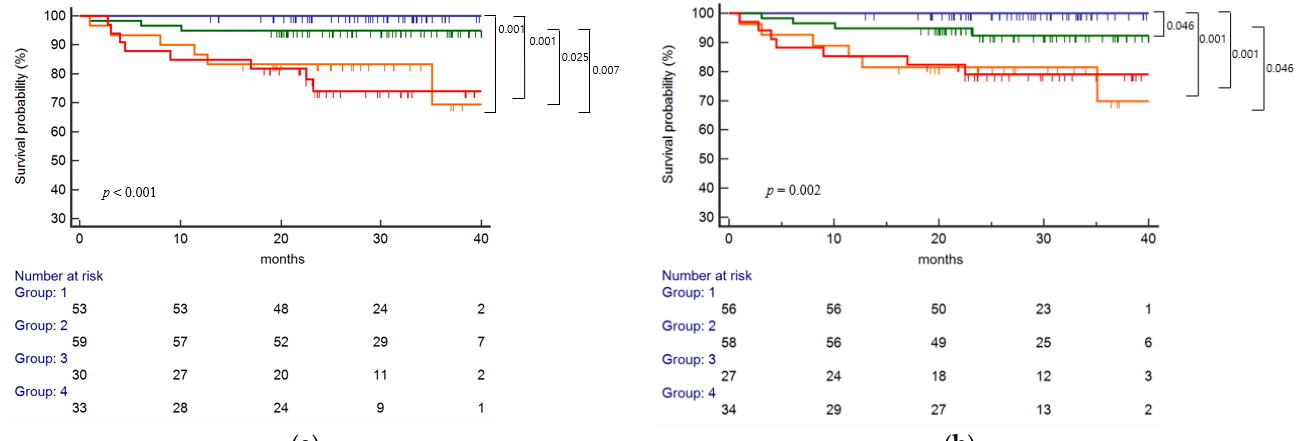
Figure 4. Combined effects of eplet mismatch and TAC-T0 on the risk of class II dnDSA develop- ment. Patients were divided into four groups based on time-weighted TAC-C0 up to post-transplant 1st year of 5 ng/mL. ( a ) Combined effects of single molecular eplet mismatch and TAC-T0 for the risk of class II dnDSA development showed worst dnDSA-free survival in group 4 ( p = 0.007) com-